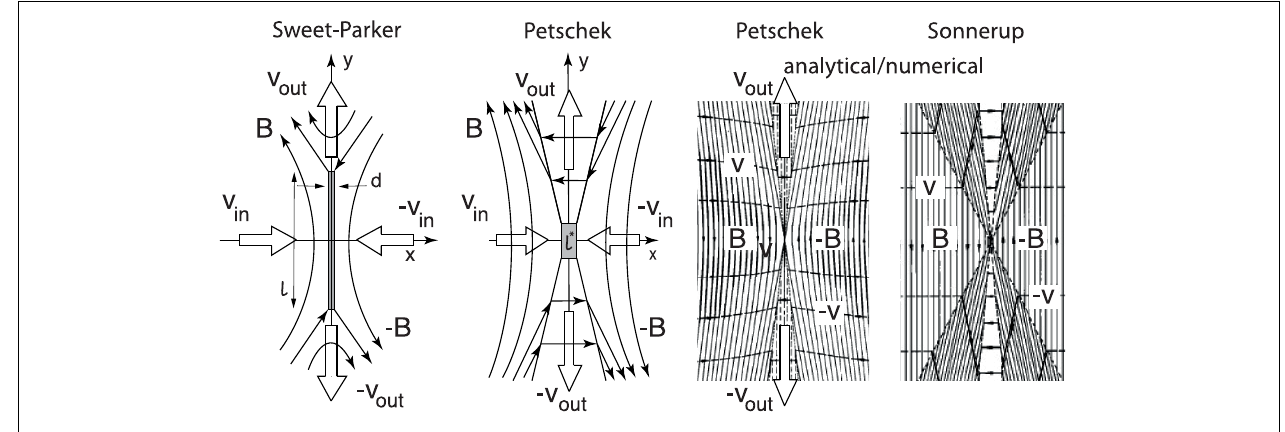
FIGURE 1 | The two basic fluid models of reconnection. Left: Sweet-Parker’s long thin current sheet model with all plasma flow across the sheet. Center: Petschek’s small (unspecified) diffusion region/slow shock model. The proposed slow shocks are the four separatirces emanating from